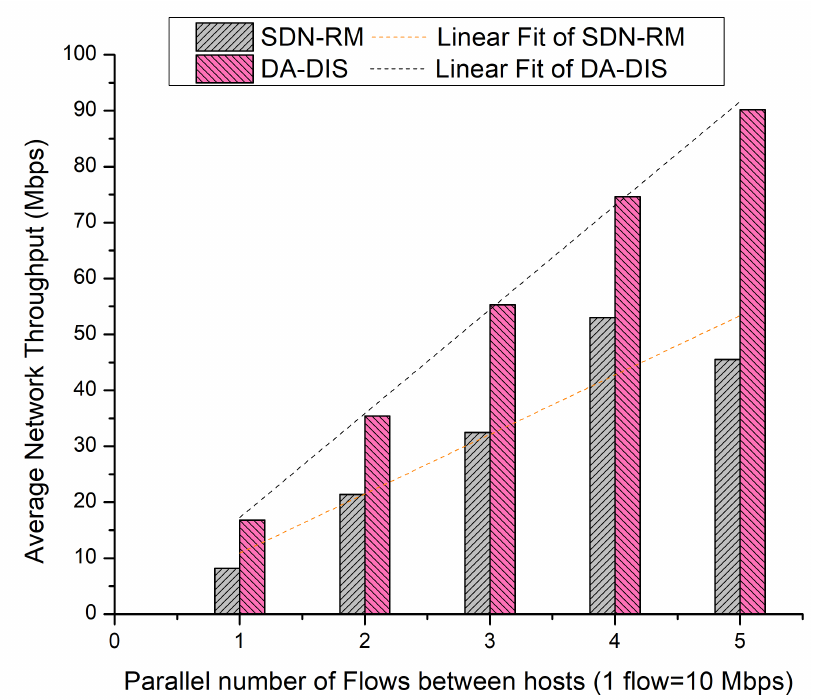
Figure 19. Throughput considering different numbers of parallel flows with one malicious switch along with E1 and E2 category faults.